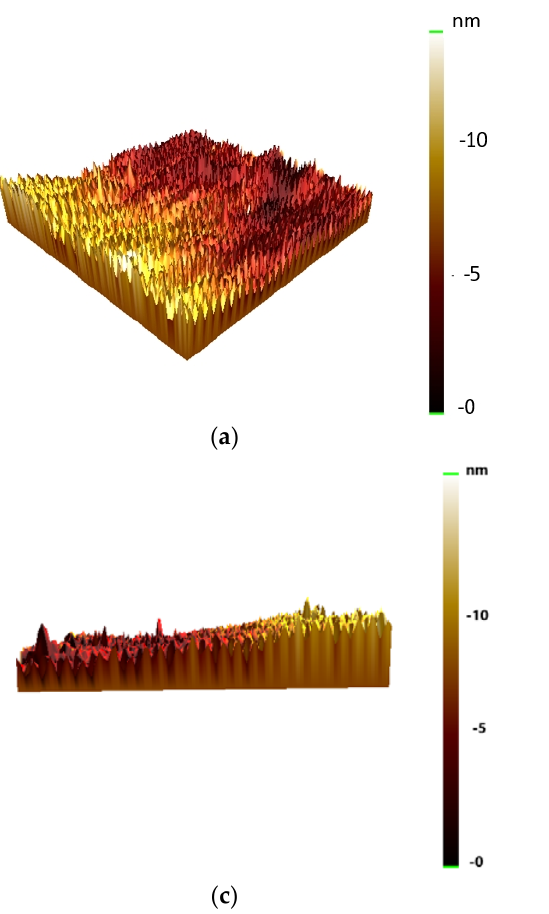
Figure 3. AFM surface morphology at RT at ( a ) 10 nm and ( b ) 40 nm. AFM pro fi les across the fi lm edge at ( c ) 10 nm and ( d ) 40 nm.